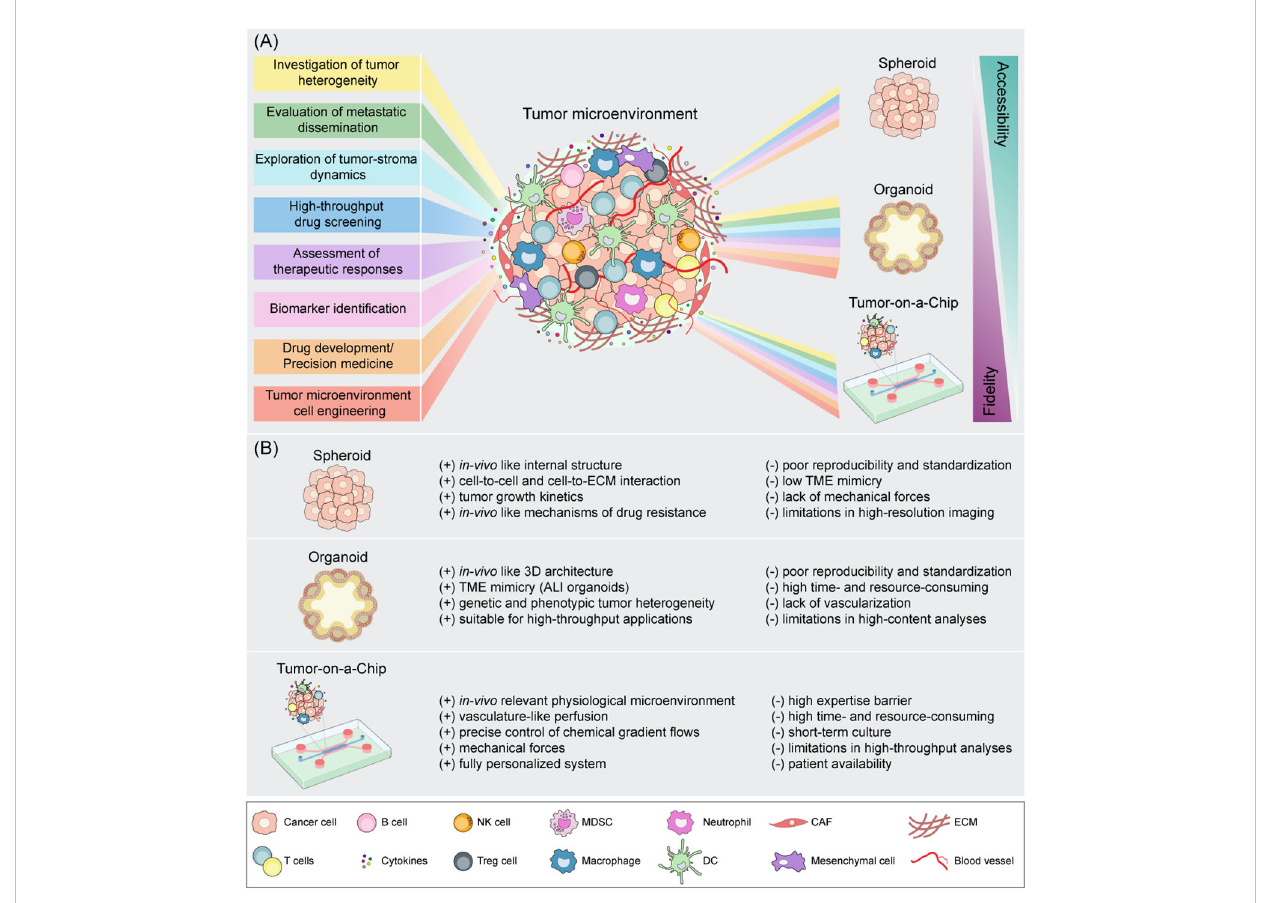
FIGURE 2 Schematic representation of spheroid, organoid and Tumor-on-a-Chip cell culture strategies for tumor microenvironment mimicking. (A) Downstream applications of state-of-the-art 3D models according to their accessibility and biological fi delity. (B) Bene fi ts (+) and drawbacks (-) of 3D in vitro models. CAF, cancer-associated fi broblast; DC, dendritic cell; ECM, extracellular matrix; NK, natural killer; MDSC, myeloid-derived suppressor cell; Treg, regulatory T